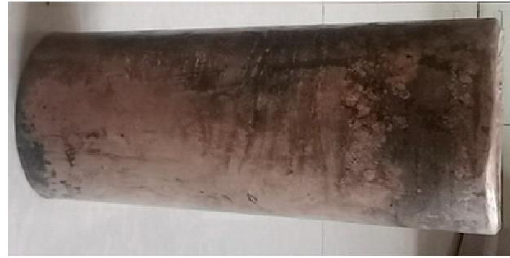
Figure 1. The ingot of the Cu–6Ni–6Sn–0.6Si alloy.